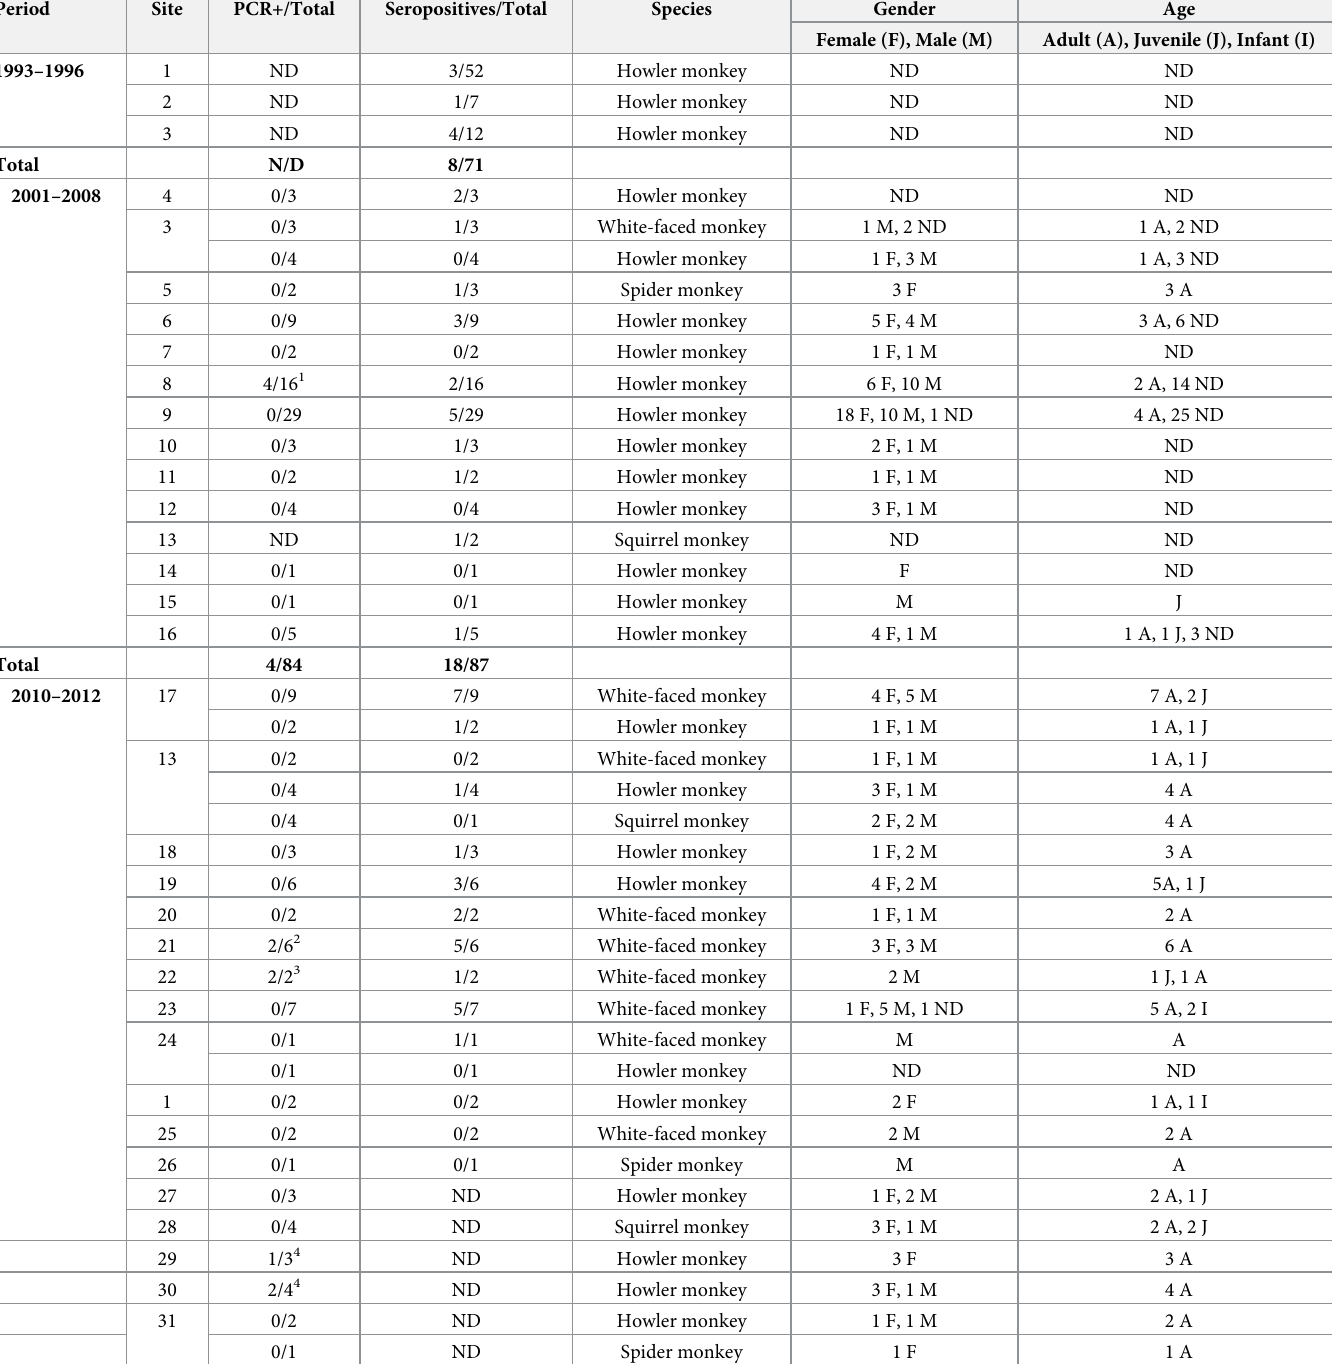
Table 2. Results of wild non-human primates analyzed for antigens and antibodies against flavivirus and antigens at various locations of Costa Rica during the period between 1993 and 2012.